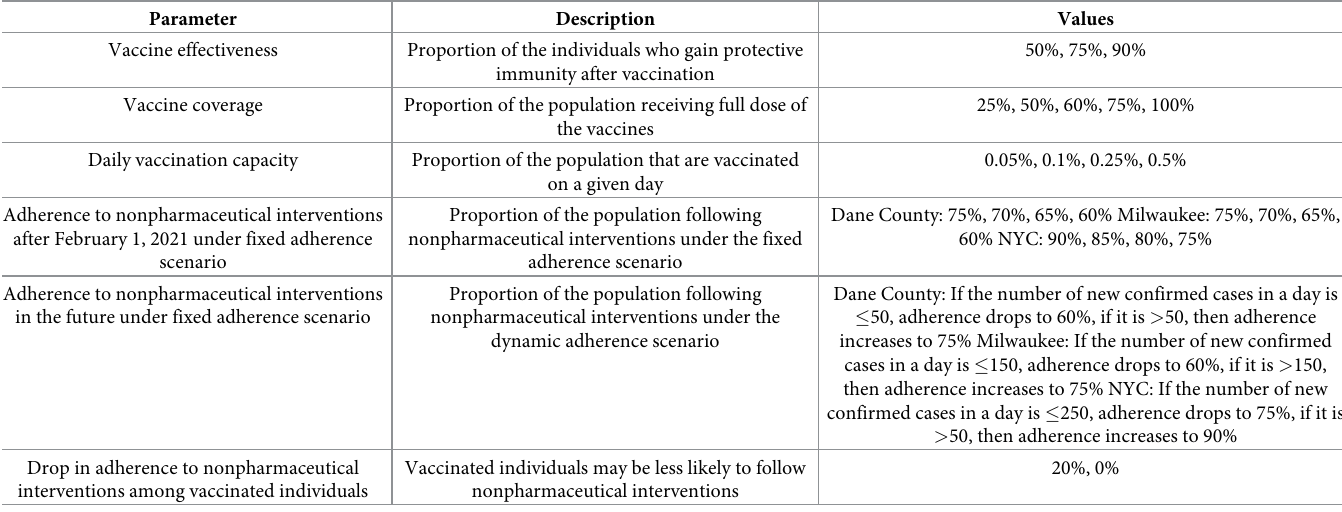
Table 1. Description of vaccination